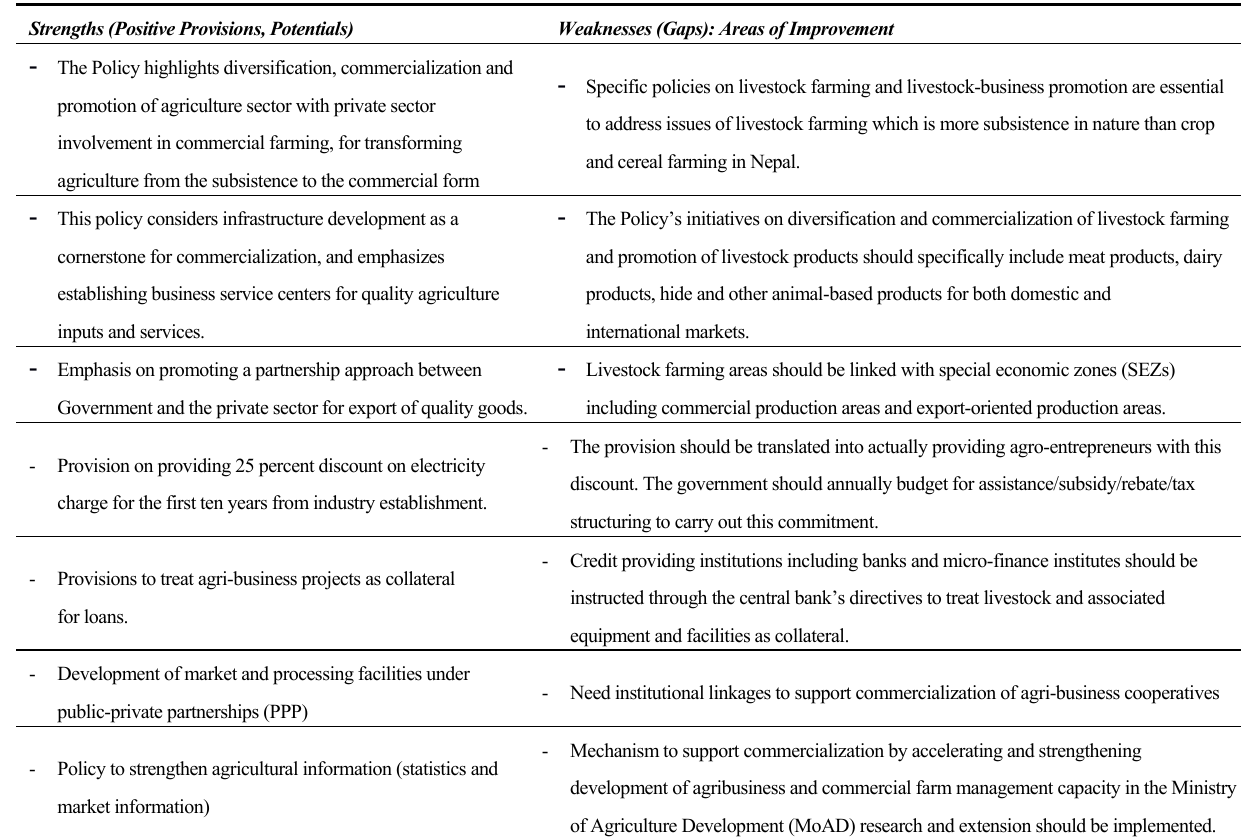
Table 3. Outcomes of SWOT analysis of Agro-Business Promotion